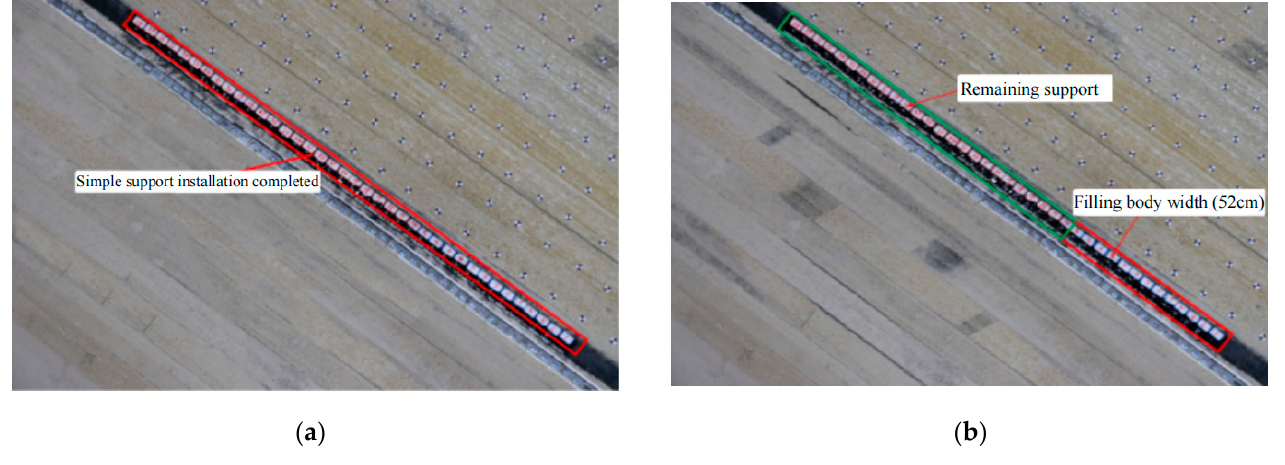
Figure 11. Model of the physical simulation experiment. ( a ) No filling; ( b ) Filling 1/3. The red mark in ( a ) shows the installation completed of simple support in no filling, the red mark and green mark in ( b ) show the filling width (52 cm) and remaining support, respectively.